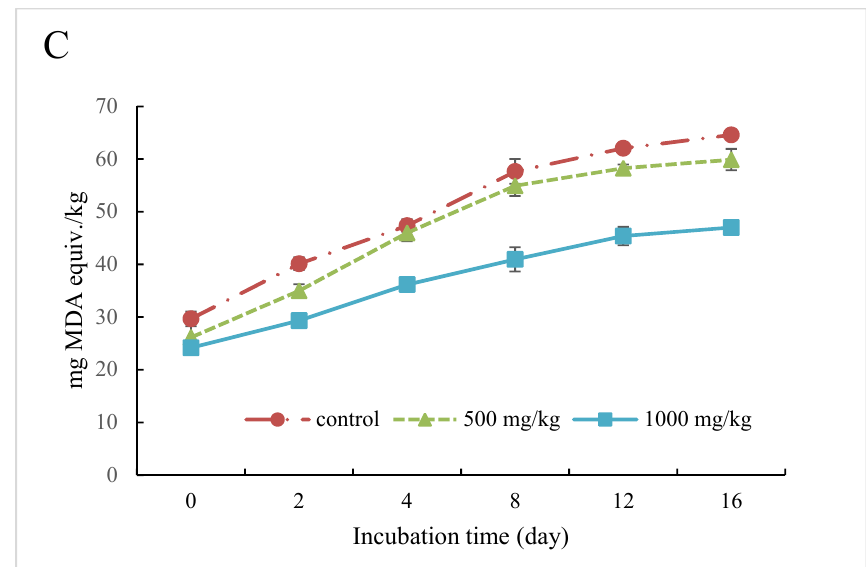
Figure 8. Thiobarbituric acid reactive substance (TBARS) value of selected peptide fractions at 0 (control), 500, and 1000 mg/kg in ground pork. ( A ) 5–10 kDa fraction ultrafiltrated from CGM